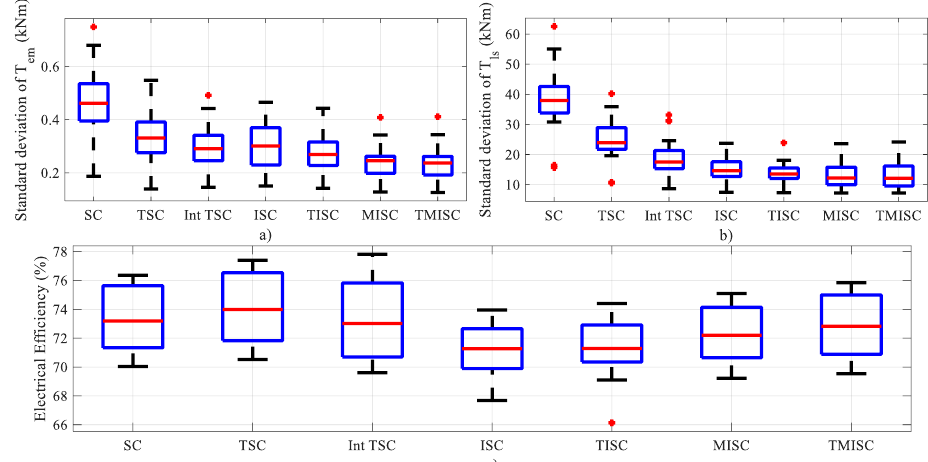
Figure 11. Overall performance of the proposed and conventional controllers. ( a ) Overall STD of T em , ( b ) overall STD of T ls and ( c ) overall electrical